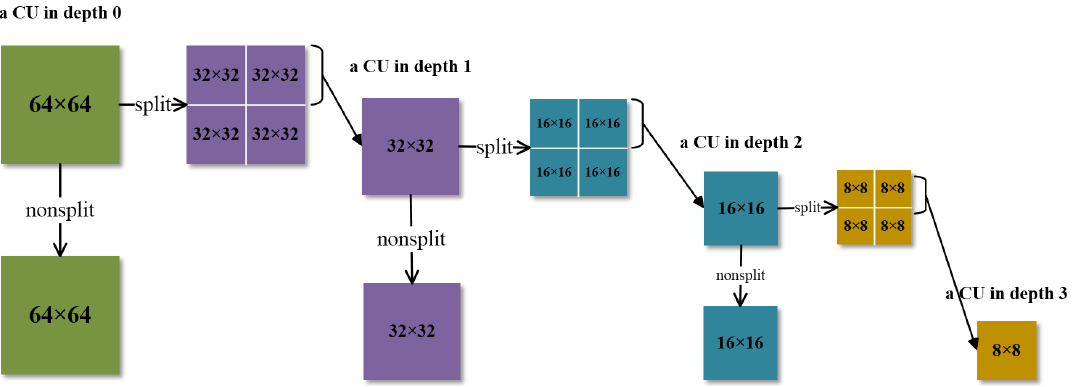
Figure 1. Recursive partition process of a CTU in the HEVC intra